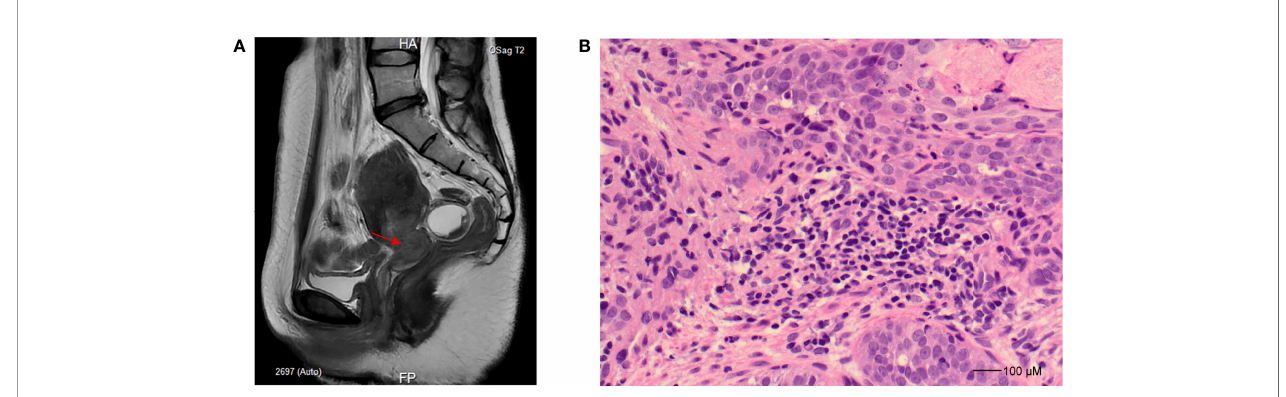
FIGURE 1 | Imaging and histopathology study for the patient. (A) Sagittal T2-weighted turbo spin-echo sequence, slightly hyperintense tumor in the cervix (indicated as an arrow). (B) Hematoxylin and eosin staining (×40) for cervical biopsy at the time of cervical cancer diagnosis demonstrates poorly differentiated squamous cell carcinoma characterized by pleomorphism and high